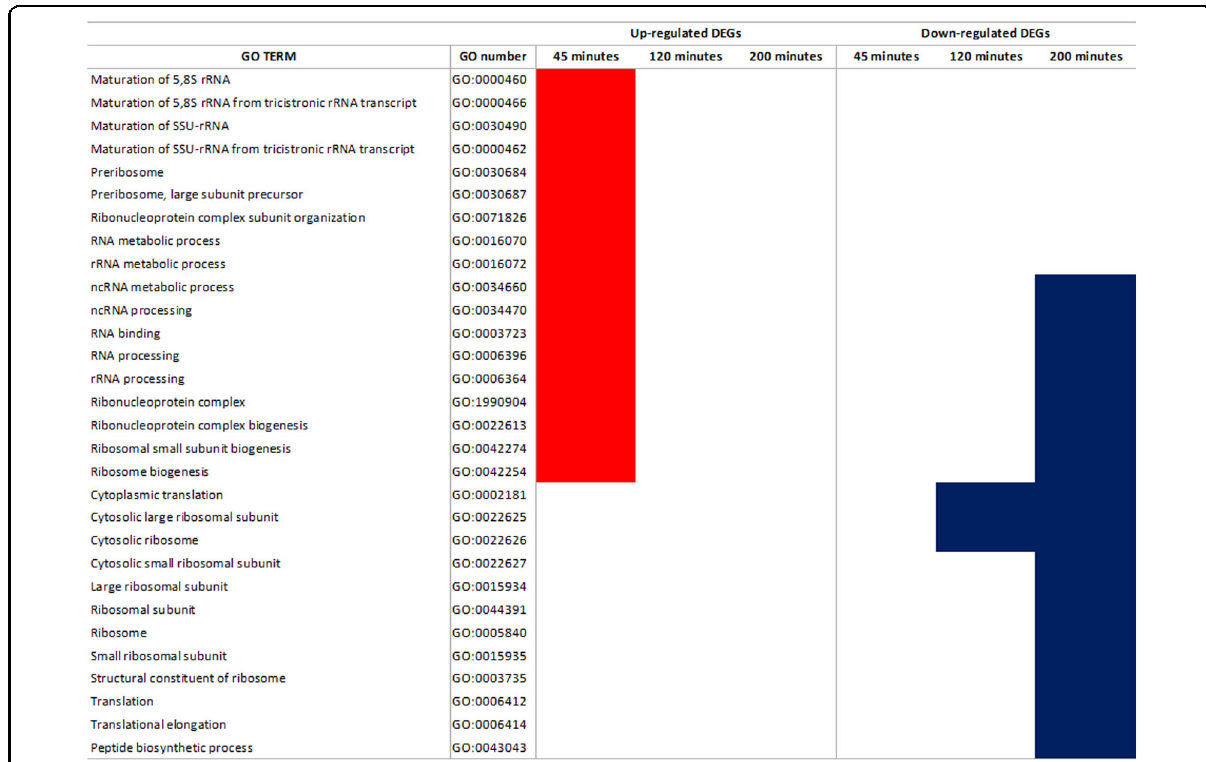
Fig. 2 Gene Ontology (GO) enrichment results. List of enriched GOs related to ribosome per exposure time. Colored cells per GO indicate signi fi cant enrichment (red for GOs related to upregulated DEGs; blue for GOs related to downregulated